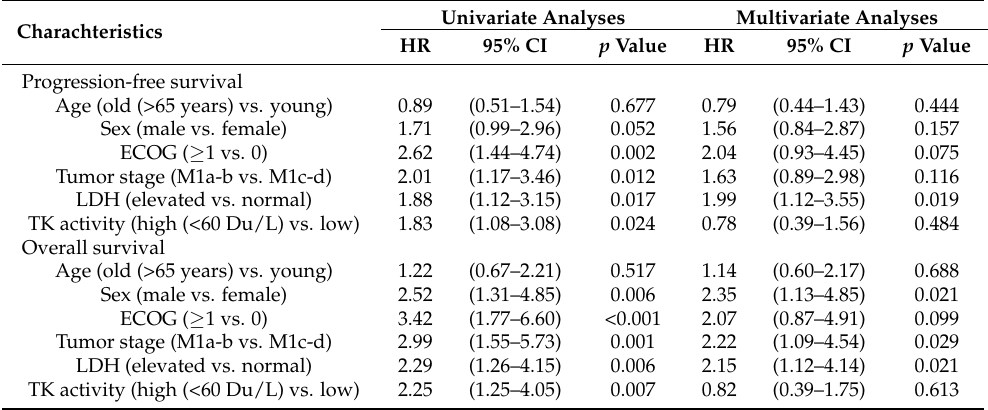
Table 4. Cox regressions for survival in metastatic melanoma patients treated with immune check- point